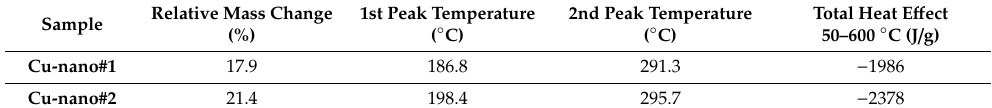
Table 3. Results of DSC (final temperature 600 ◦ C).